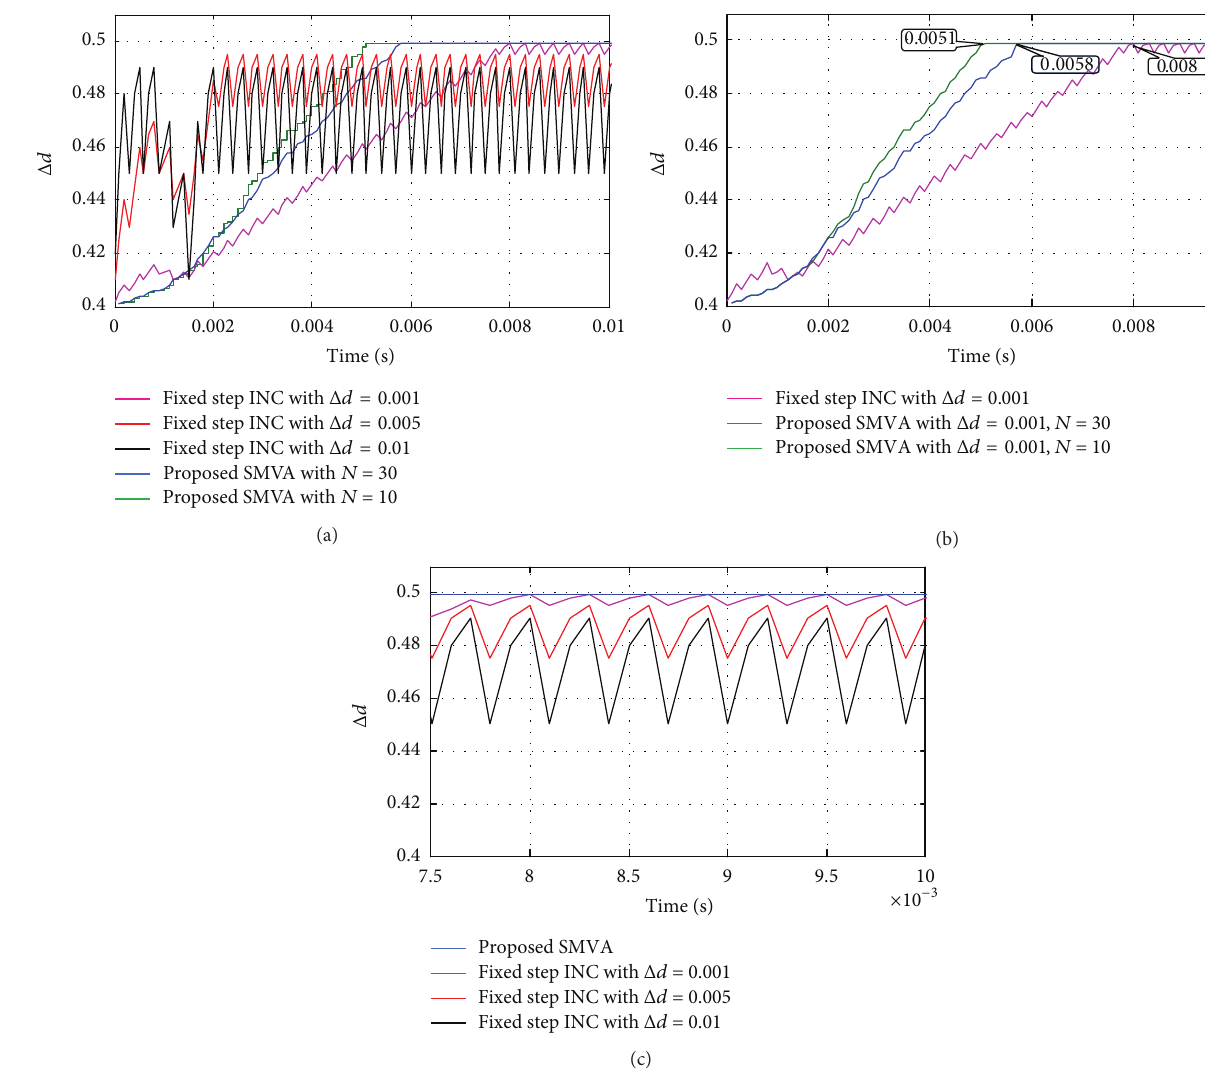
Figure 11: Duty cycle: fixed step INC controller with Δ𝑑 = 0.001 , 0.005, and 0.01 and proposed method with 𝑁 = 10 and 30.